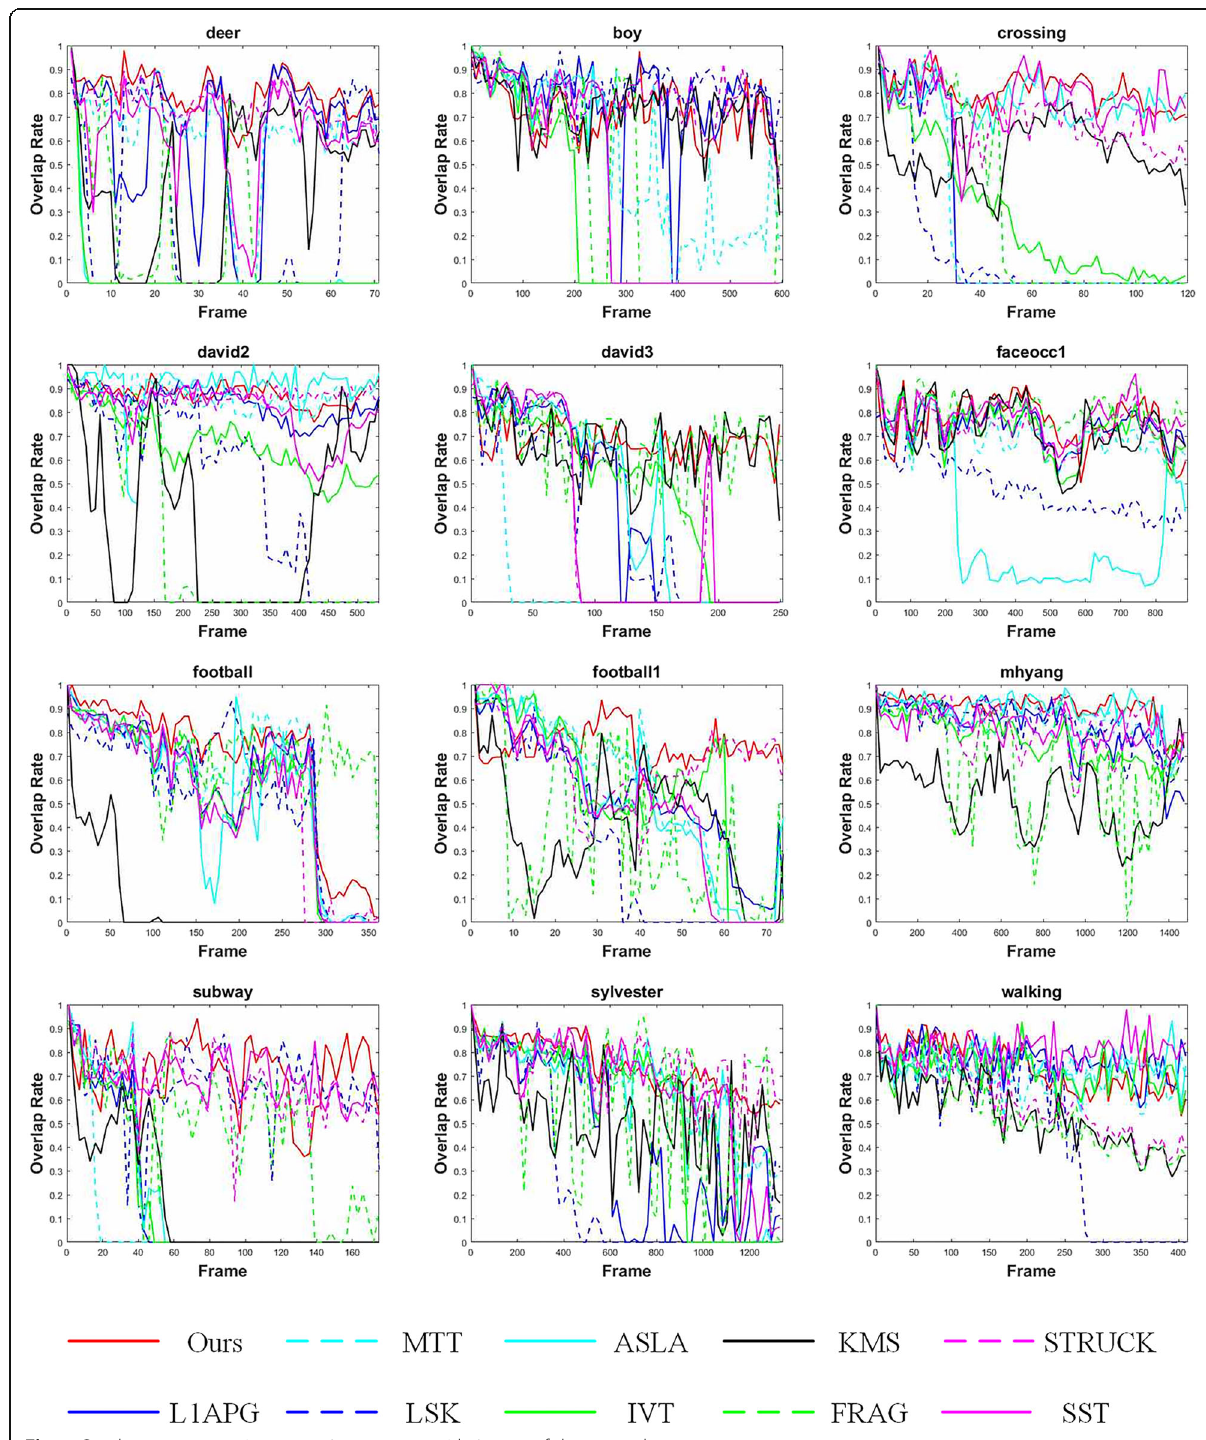
Fig. 4 Overlap rate comparisons on 12 sequences with 9 state-of-the-art